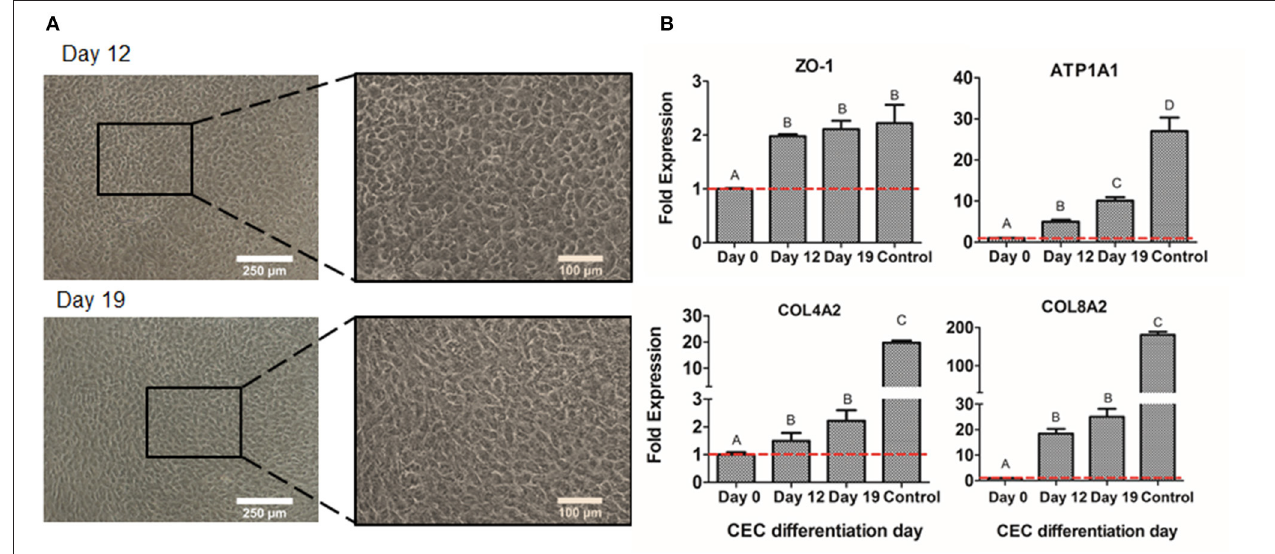
FIGURE 7 | CEC differentiation from DPSC. Microscope images of CEC-derived from DPSC at days 12 and 19 (A) . Relative mRNA expression in CEC-derived from DPSC, at days 0, 4, and 19 of CEC markers ZO-1, ATP1A1, COL4A2, and COL8A2, by quantitative RT-PCR (B) . *Scale bars: 250 µ m (lower magnification) and 100 µ m (higher magnification). **Data presented are means ± SD, n = 3 technical replicates per experimental group. Different letter denotes significant differences ( p < 0.05). Same letter denotes non-significant